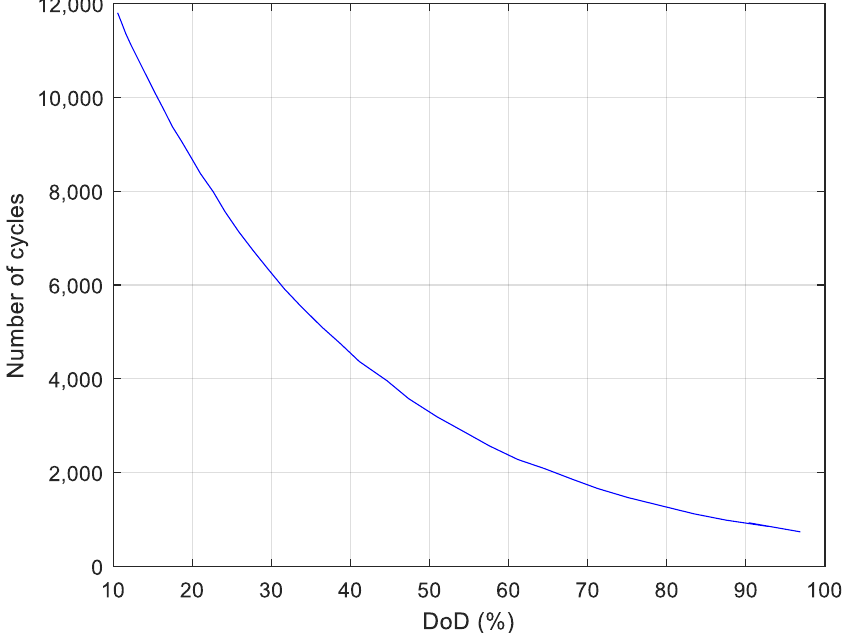
Figure 1. Example of the relationship between the cycles and depth of discharge ( DoD ) of a commercial battery [28].